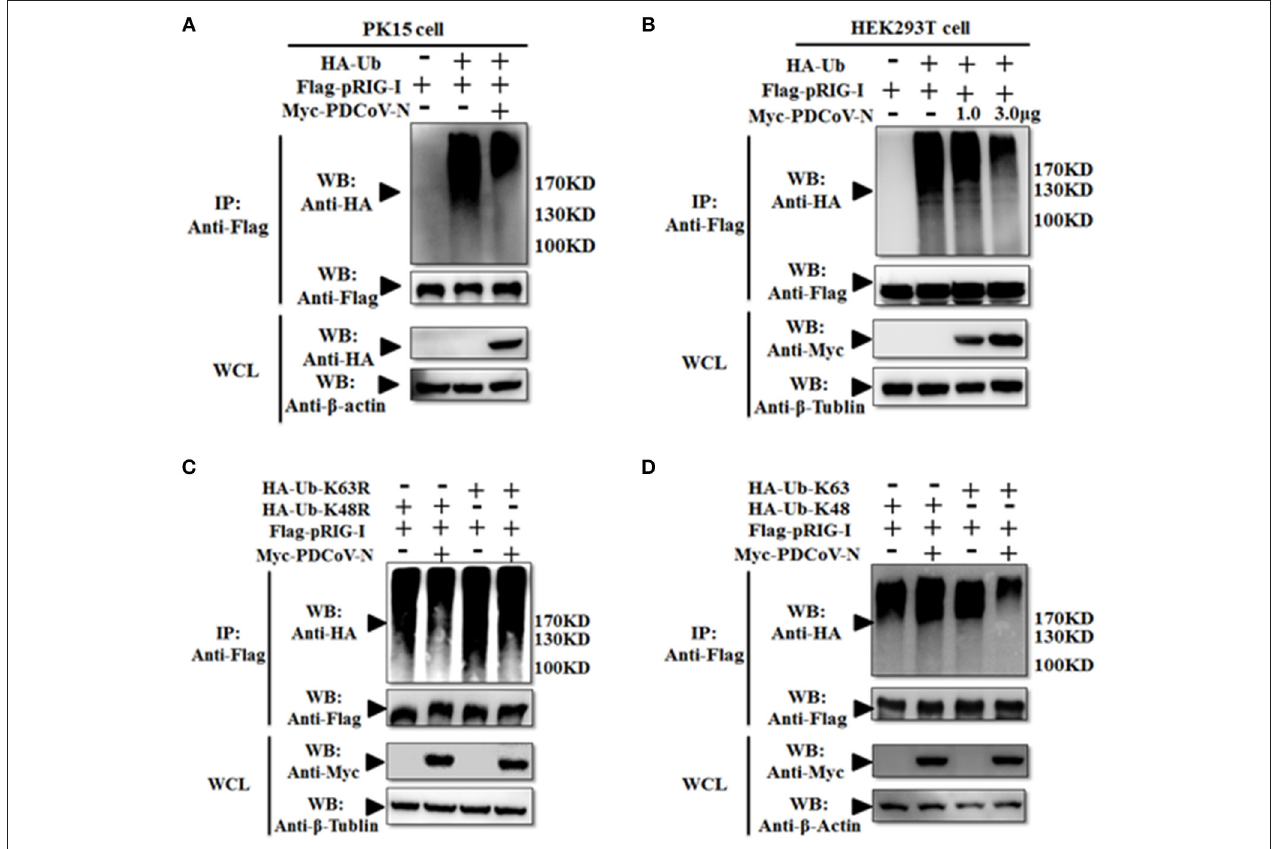
FIGURE 5 | PDCoV N protein inhibited the pRIG-I K63-linked polyubiquitination. (A,B) HEK293T or PK-15 were cotransfected with Flag-tagged pRIG-I and Myc-tagged PDCoV N or empty control plasmid with HA-tagged ubiquitin (HA-Ub) or empty control plasmid. (C,D) HEK293T cells were cotransfected Flag-tagged pRIG-I and Myc-tagged PDCoV N or empty control plasmid with HA-Ub K48R, K63R, K48 only, or K63 only mutant plasmid or empty control plasmid, respectively. After 28h of transfection, the cells were lysed for Co-IP by Flag-affinity gel. Western blot was used to detect the immunoprecipitants and WCLs